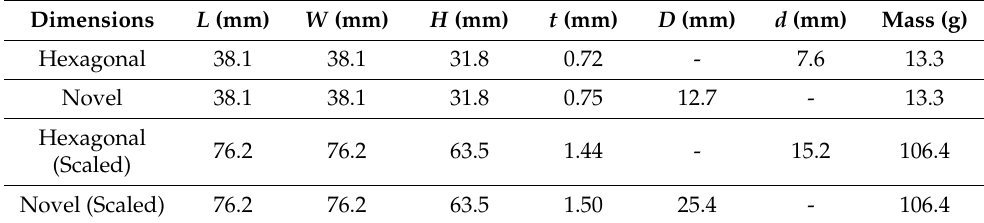
Table 1. Dimensions and mass of the four combinations of sample geometry and dimensional scale. The parameters L , W , H , t , D , and d are indicated in Figure 2.